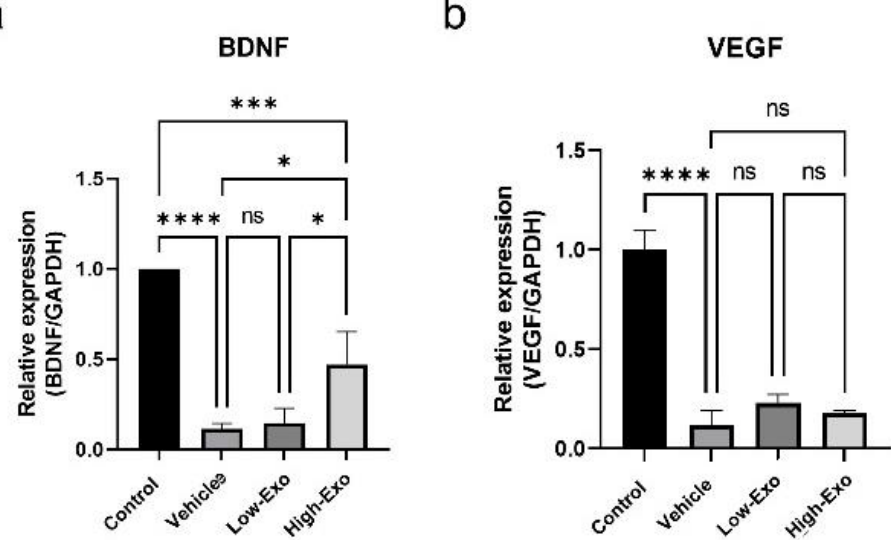
Figure 5. Gene expression levels in rats of the control and SCI groups: ( a , b ) expression patterns of BDNF and VEGF measured by qPCR (* p ≤ 0.05, *** p ≤ 0.001, **** p ≤ 0.0001, ns = not significant).